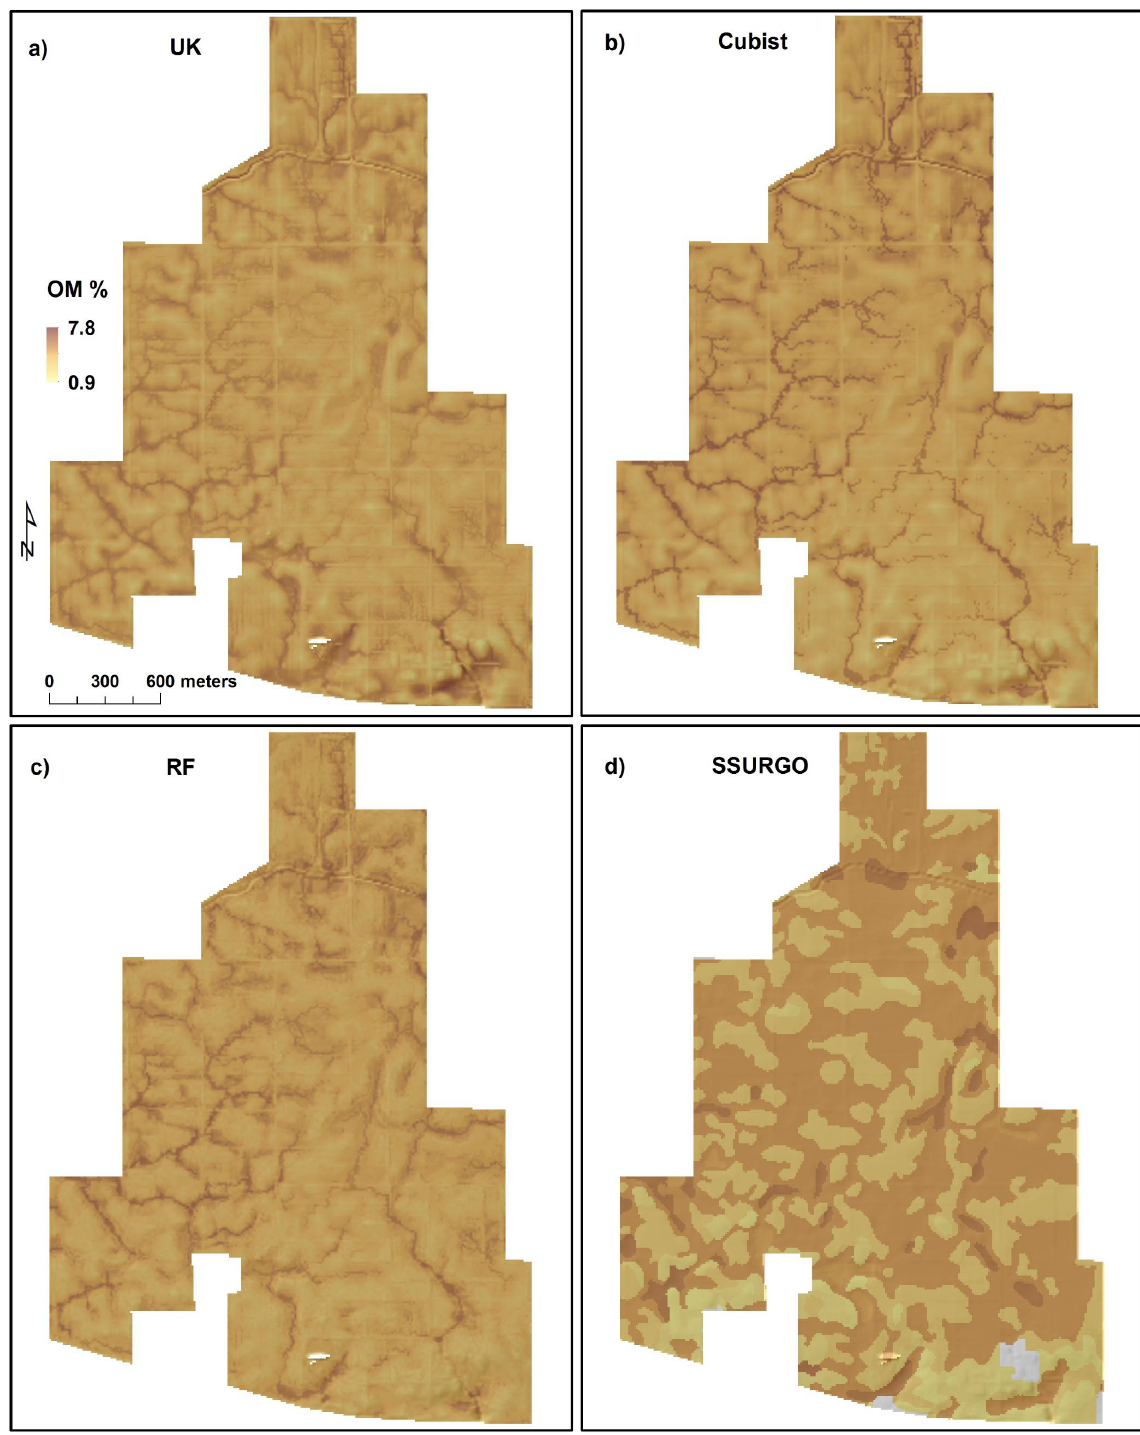
Figure 7. Soil organic matter content (SOM) prediction. ( a ) Universal kriging (UK), ( b ) Cubist, ( c ) random forest (RF), and ( d ) soil survey geographic (SSURGO).